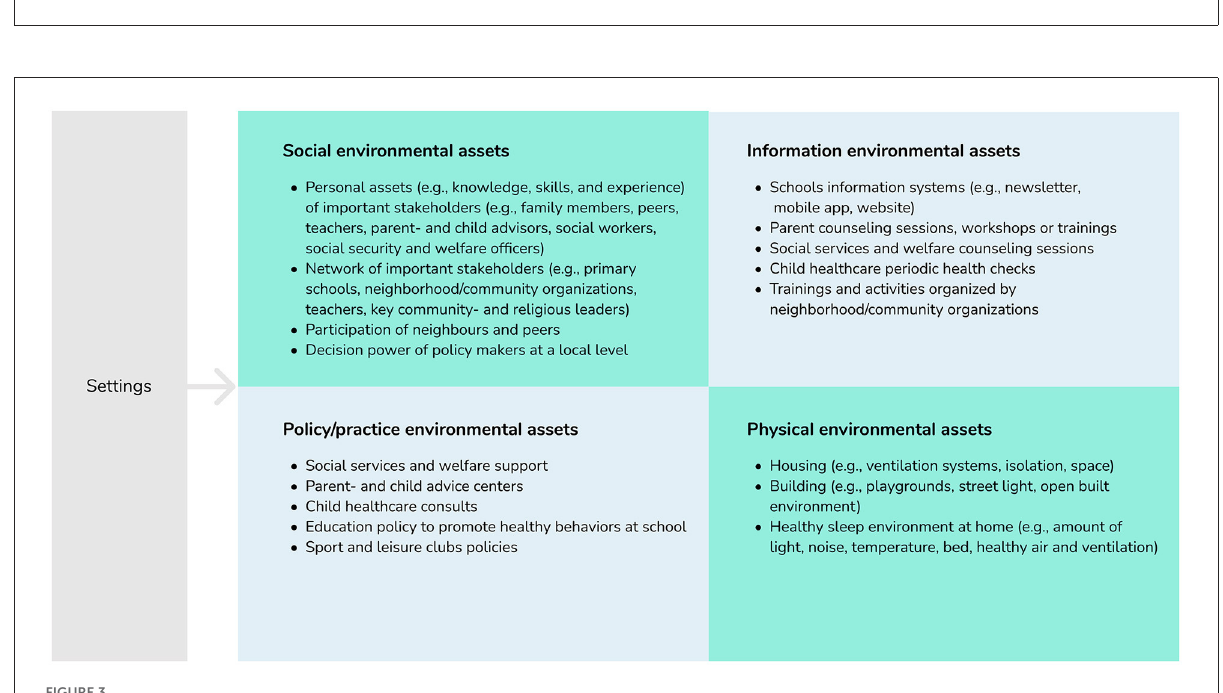
FIGURE3 Environmental asset assessment, examples per